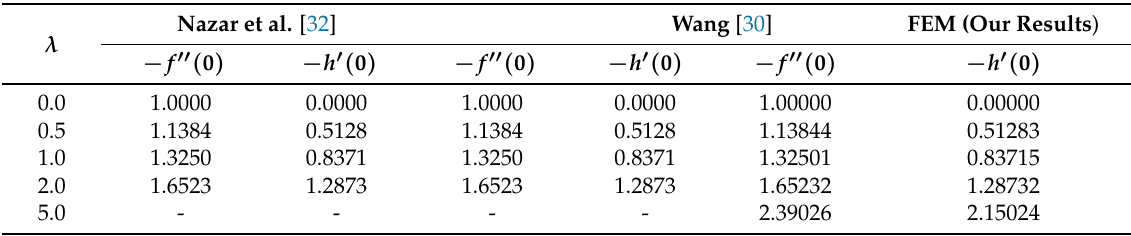
Table 4. g (cid:48) ( 0 ) and f (cid:48)(cid:48) ( 0 ) value along with diverse values of λ at ζ = 1 when remaining parameters are zeros.